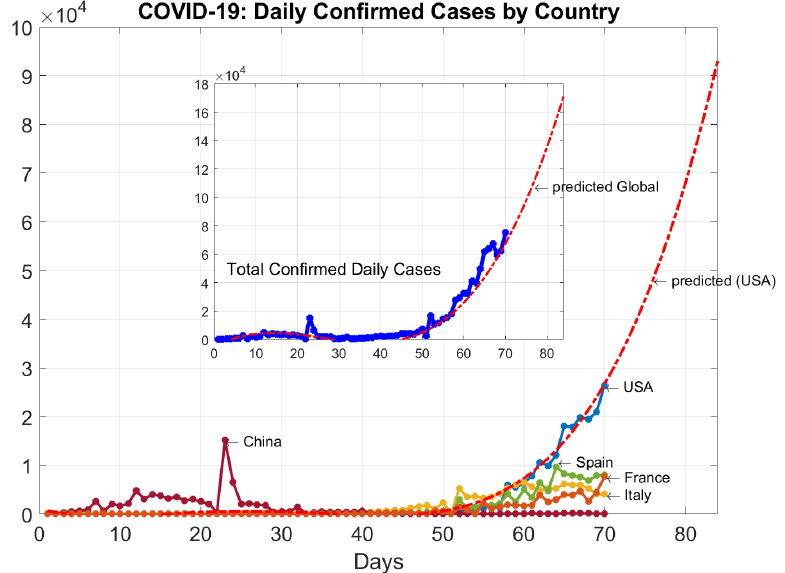
Figure 8. Number of daily confirmed cases of COVID-19 from 22 January to 31 March and the prediction based on the statistical power series model in the following projected two weeks (until 14